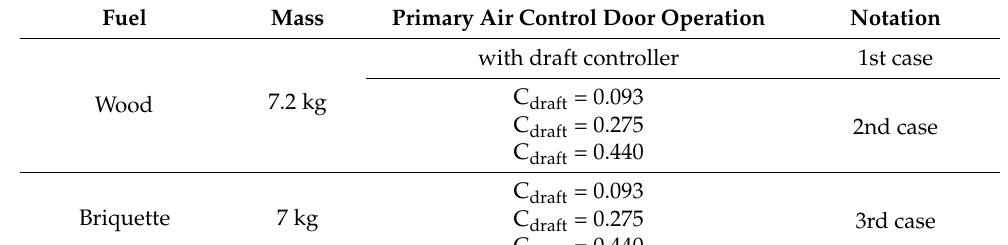
00.050.10.150.20.25 0510152025